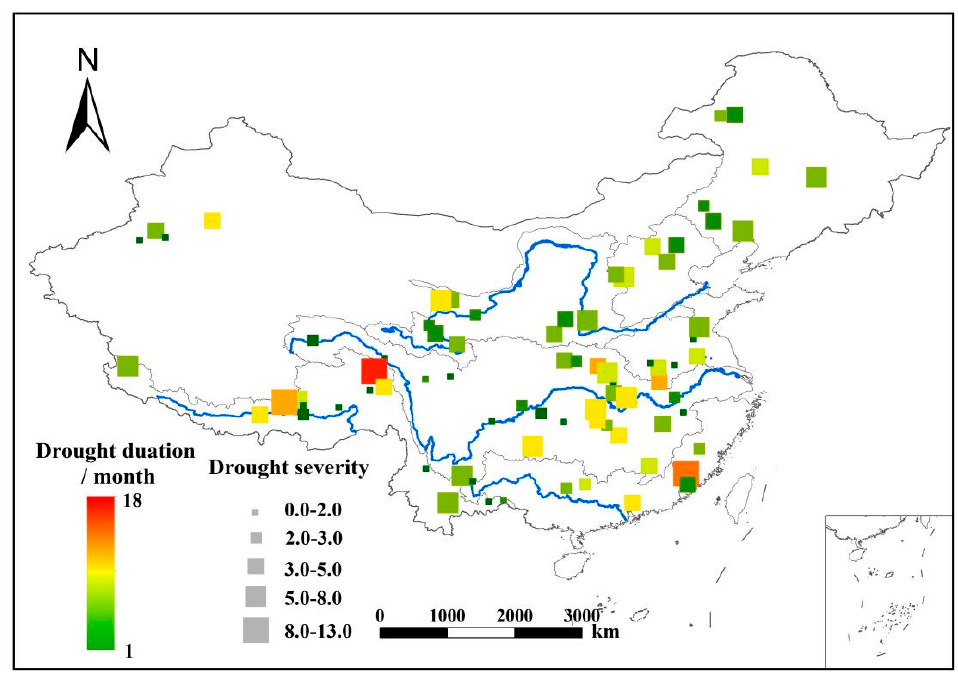
Figure 9. Distribution of Dd and Ds for the most severe drought events for each station during 1996–2016.